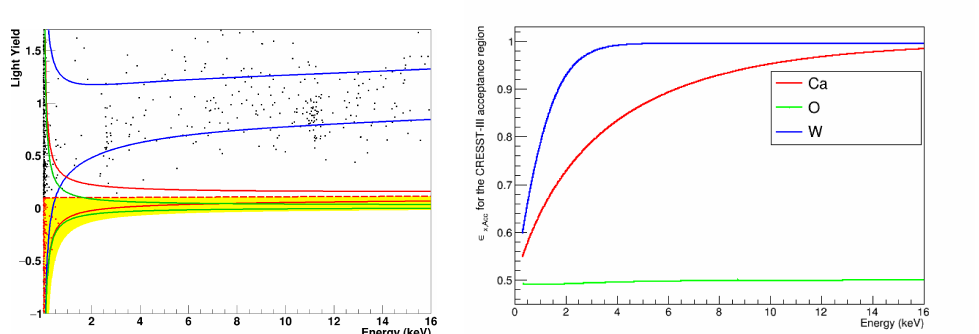
Figure 13: Analysis space and efficiencies for the CRESST-III dark matter search. Left: Electron (blue), oxygen (red), and tungsten-recoil bands (green). The bands have been fitted to the neutron calibration data and are required for the definition of the acceptance region (yellow) in the blind data. Right: The fraction of accepted events in the nuclear recoil bands, per nuclear species as a function of the reconstructed energy. Plots taken from [ 156 ]